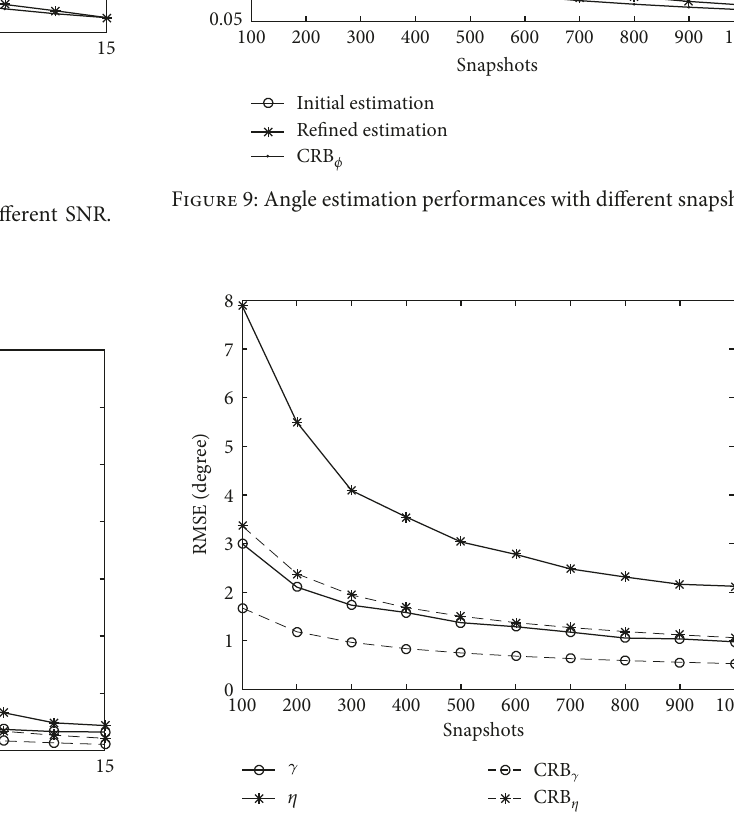
Figure 10: Polarization parameters estimation performances with different